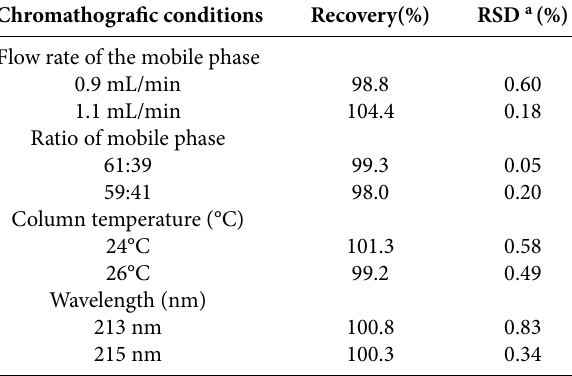
Table 5 . Robustness of the analytical method for insulin quantifica- tion Chromathografic conditions